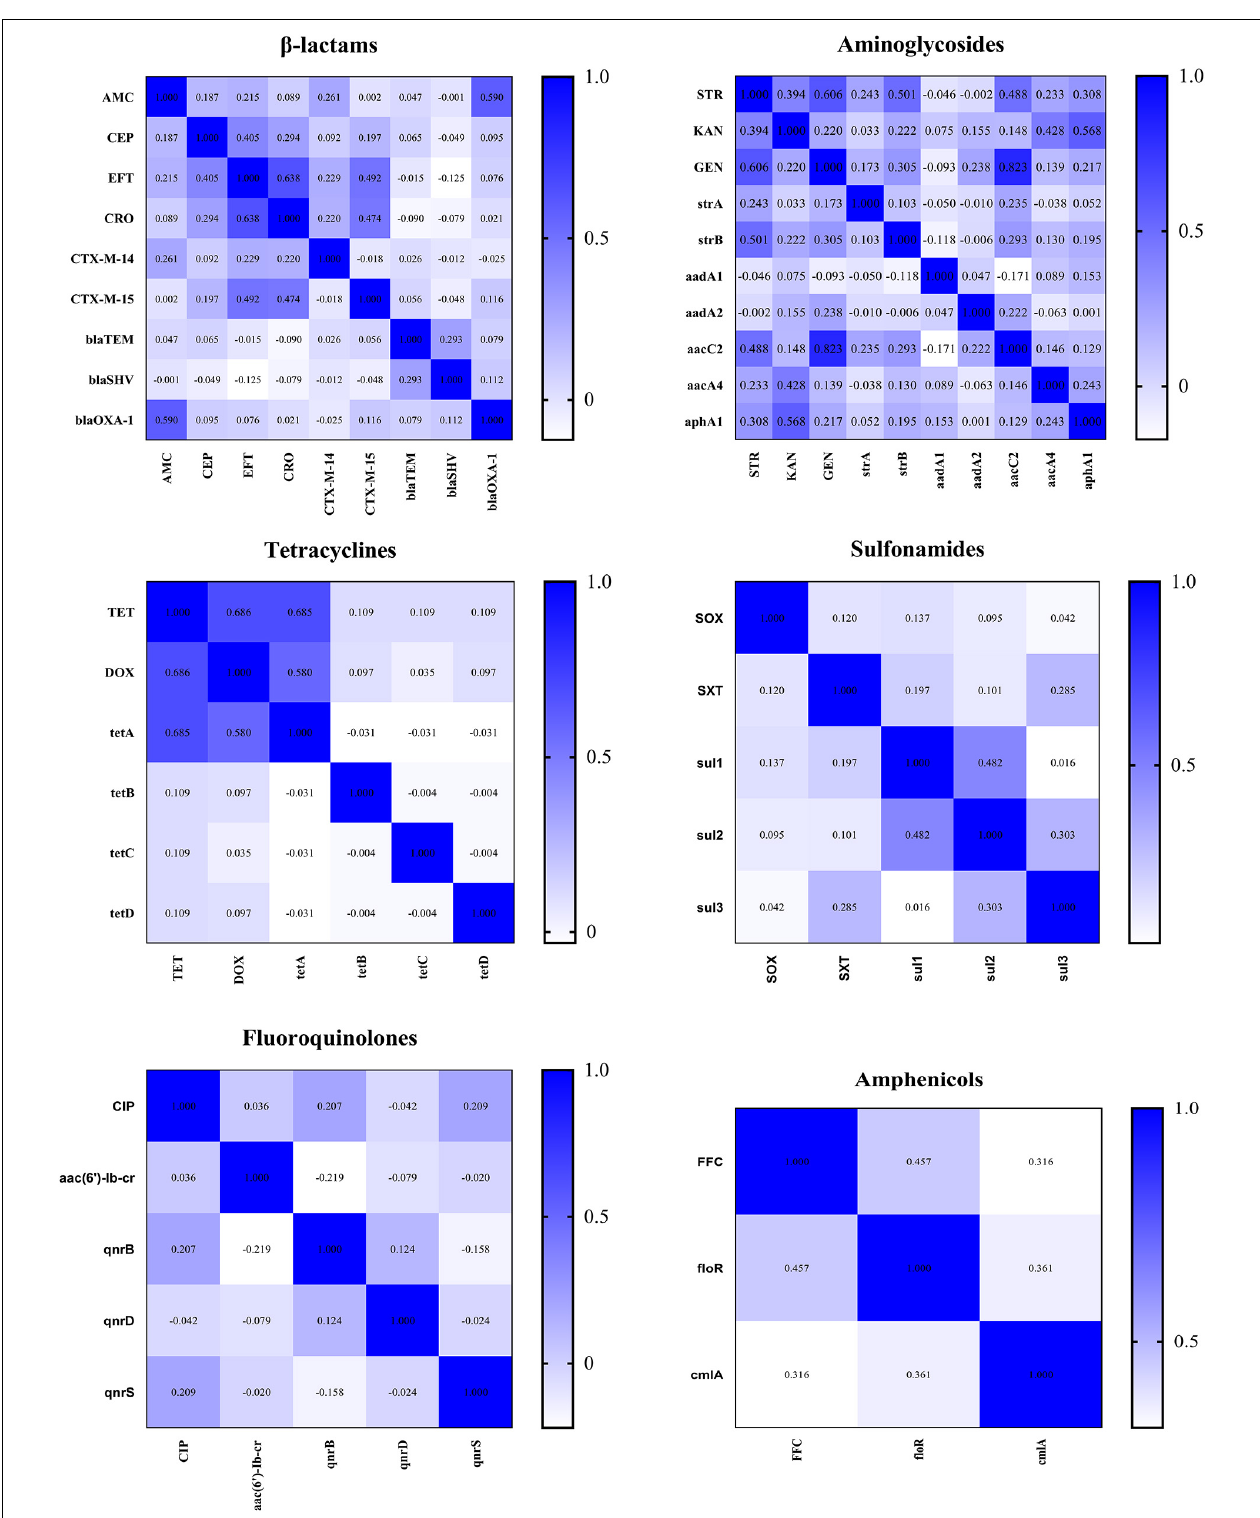
FIGURE 8 | Correlations between different classes of antimicrobials and resistance genes. The intensity of the color indicates the numerical value of the correlation coefficient (r).